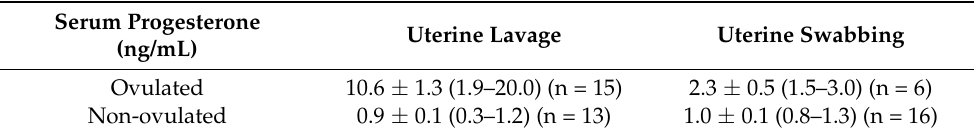
Table 3. Serum levels of progesterone in the different evaluated groups. Values are expressed as means ± SEM (range).